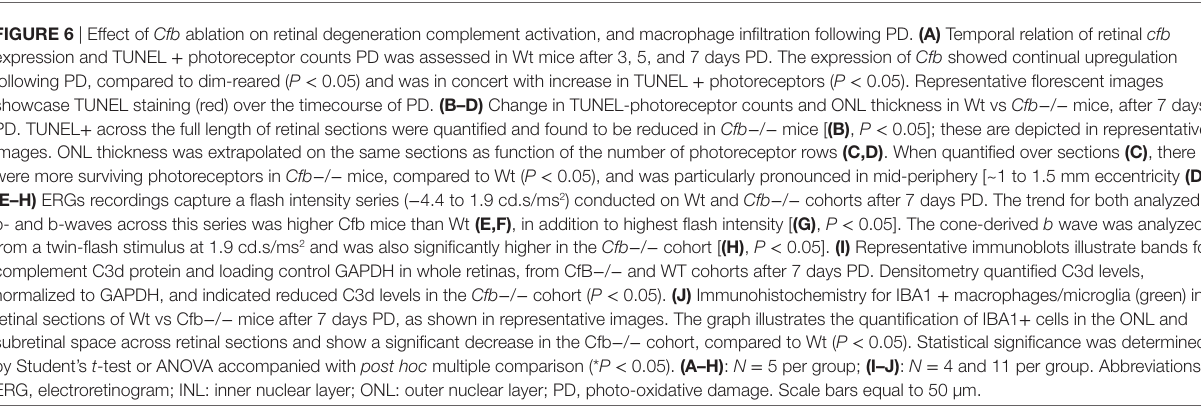
FigUre 6 | Effect of Cfb ablation on retinal degeneration complement activation, and macrophage infiltration following PD. (a) Temporal relation of retinal cfb expression and TUNEL + photoreceptor counts PD was assessed in Wt mice after 3, 5, and 7 days PD. The expression of Cfb showed continual upregulation following PD, compared to dim-reared ( P < 0.05) and was in concert with increase in TUNEL + photoreceptors ( P < 0.05). Representative florescent images showcase TUNEL staining (red) over the timecourse of PD. (B–D) Change in TUNEL-photoreceptor counts and ONL thickness in Wt vs Cfb − / − mice, after 7 days PD. TUNEL + across the full length of retinal sections were quantified and found to be reduced in Cfb − / − mice [ (B) , P < 0.05]; these are depicted in representative images. ONL thickness was extrapolated on the same sections as function of the number of photoreceptor rows (c,D) . When quantified over sections (c) , there were more surviving photoreceptors in Cfb − / − mice, compared to Wt ( P < 0.05), and was particularly pronounced in mid-periphery [~1 to 1.5 mm eccentricity (D) ]. (e–h) ERGs recordings capture a flash intensity series ( − 4.4 to 1.9 cd.s/ms 2 ) conducted on Wt and Cfb − / − cohorts after 7 days PD. The trend for both analyzed b- and b-waves across this series was higher Cfb mice than Wt (e,F) , in addition to highest flash intensity [ (g) , P < 0.05]. The cone-derived b wave was analyzed at from a twin-flash stimulus at 1.9 cd.s/ms 2 and was also significantly higher in the Cfb − / − cohort [ (h) , P < 0.05]. (i) Representative immunoblots illustrate bands for complement C3d protein and loading control GAPDH in whole retinas, from CfB − / − and WT cohorts after 7 days PD. Densitometry quantified C3d levels, normalized to GAPDH, and indicated reduced C3d levels in the Cfb − / − cohort ( P < 0.05). (J) Immunohistochemistry for IBA1 + macrophages/microglia (green) in retinal sections of Wt vs Cfb − / − mice after 7 days PD, as shown in representative images. The graph illustrates the quantification of IBA1 + cells in the ONL and subretinal space across retinal sections and show a significant decrease in the Cfb − / − cohort, compared to Wt ( P < 0.05). Statistical significance was determined by Student’s t -test or ANOVA accompanied with post hoc multiple comparison (* P < 0.05). (a–h) : N = 5 per group; (i–J) : N = 4 and 11 per group. Abbreviations: ERG, electroretinogram; INL: inner nuclear layer; ONL: outer nuclear layer; PD, photo-oxidative damage. Scale bars equal to 50